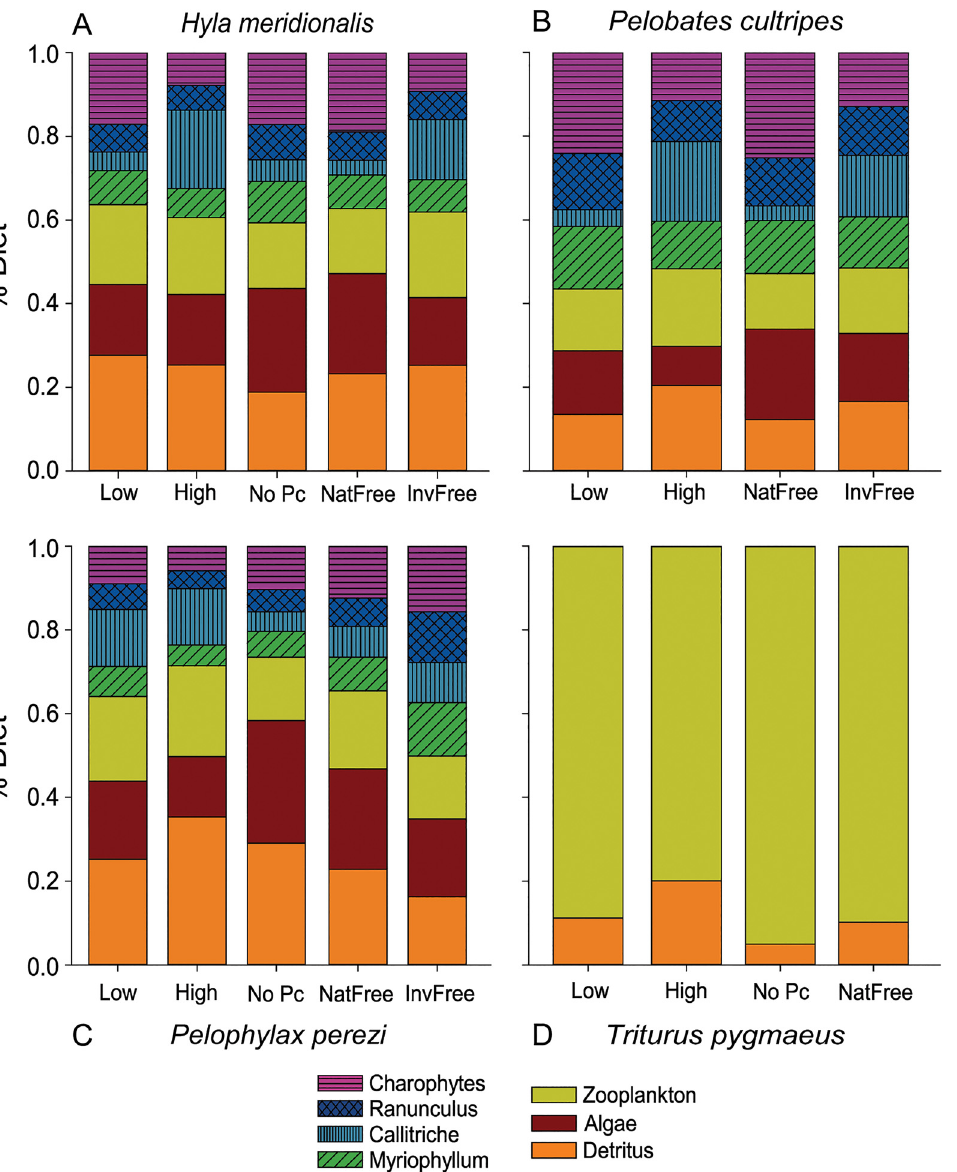
Fig 4. Potential contribution of different food sources to the diet of each amphibian species. Mean estimated proportion of each of the seven potential sources (detritus, algae, zooplankton, and four types of macrophytes) in the diet of three anuran species under five different ecological scenarios: low and high larval density, absence of spadefoot toads ( P . cultripes ), presence of free native dytiscid beetles, or presence of invasive red swamp crayfish. In the case of newts ( T . pygmaeus ), only two sources were considered since they do not consume macrophytes or algae. Also, no newts survived the presence of free